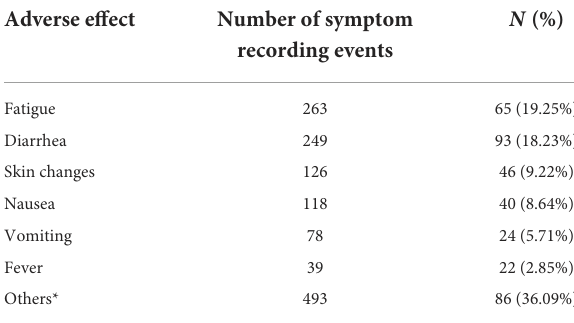
TABLE 2 The adverse effects and their frequency recorded by patients in the